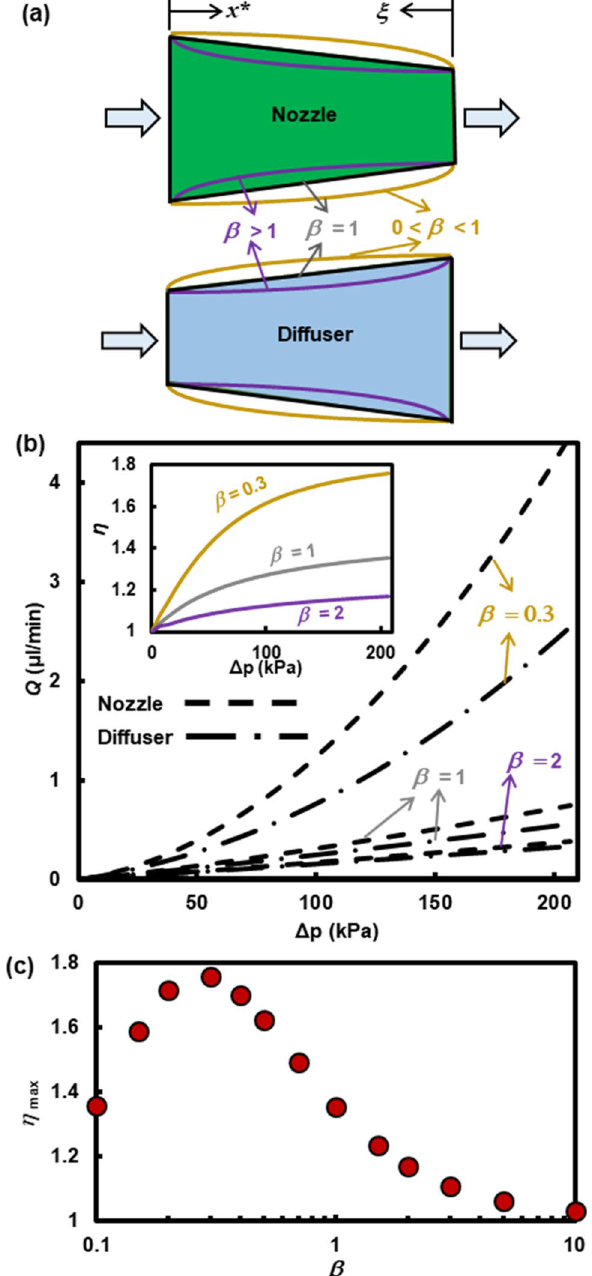
Figure 5. ( a ) Schematic diagrams of the nonlinear width profiles characterized by a parameter β for the ( W i W o W o )ξ β , and the diffuser direction, W D nozzle direction, W N = + − Volumetric flow rates, Q , of water calculated from the fluid–solid-mechanics model as a function of pressure difference, (cid:31) p , across the deformable nozzle/diffuser microchannels ( W small H 0 1.25 ◦ ) with three different β values (0.3, 1, and 2). The inset shows the rectification 2.6 µ m , and θ = = ratio, η , as a function of (cid:31) p . ( c ) The maximum η for the microchannels as a function of the nonlinear sidewall parameter β over (cid:31) p of 14–206